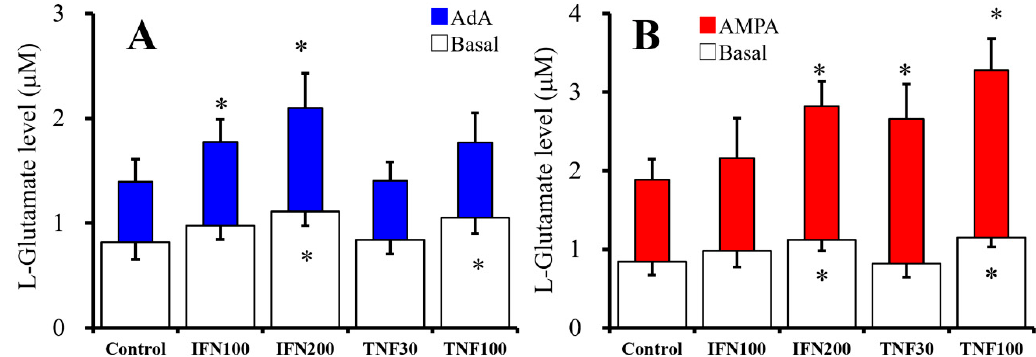
Figure 1. Effects of chronic administration of interferon γ (IFN γ ) and tumor necrosis factor α (TNF α ) for seven days on basal, 1 μ M adenophostin-A (AdA)- and 100 μ M 2-amino-3-(3-hydroxy-5-methyl- isoxazol-4-yl)propanoic acid (AMPA)-evoked astroglial L-glutamate releases.